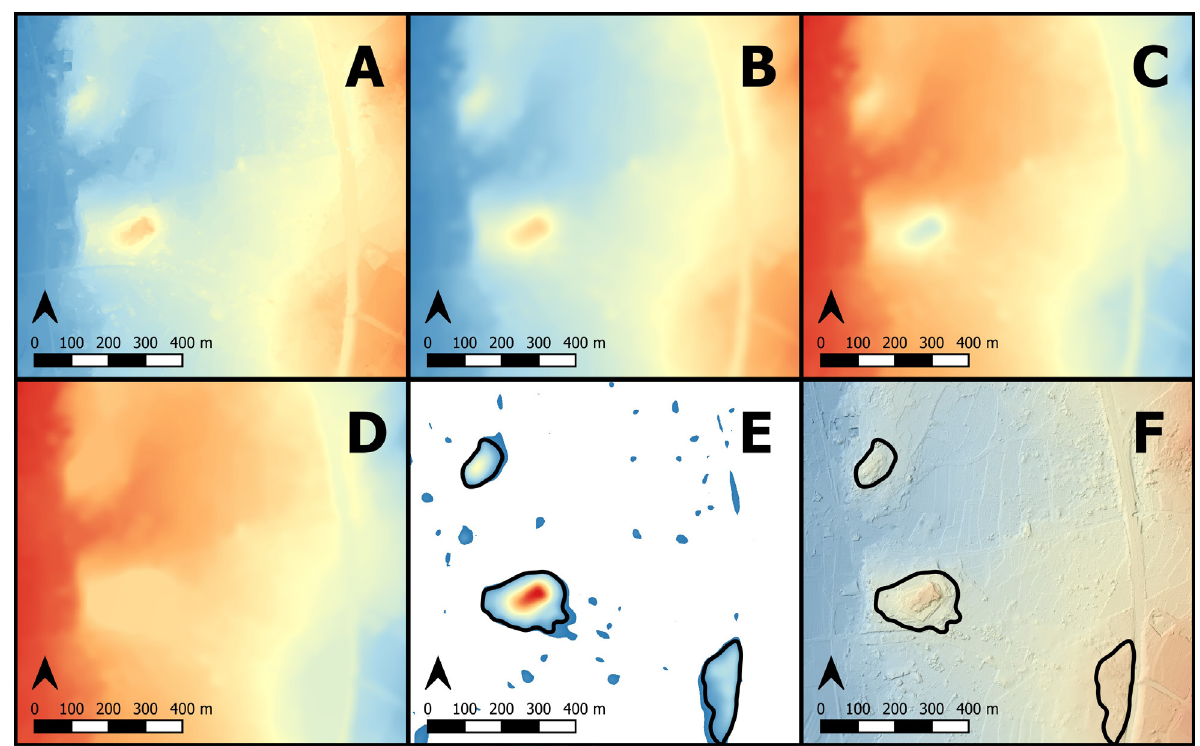
Figure 5: Step by step calculation of the iMounds on an example near Enfeh. A) Input DTM. B) Application of a low-pass filter. C) Inverting the model. D) Filling sinks after Wang and Liu (2006). E) Subtraction of the filled model from the input model and application of a 1 m threshold for minimum mound height (encircled in black). F) Digitized iMounds mapped on the input DTM visualized by